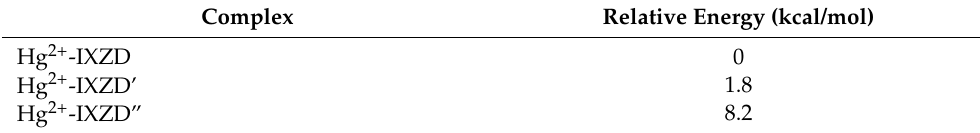
Table 2. Values of relative energies of the Hg 2+ Complexes with solvation model SMD and water.